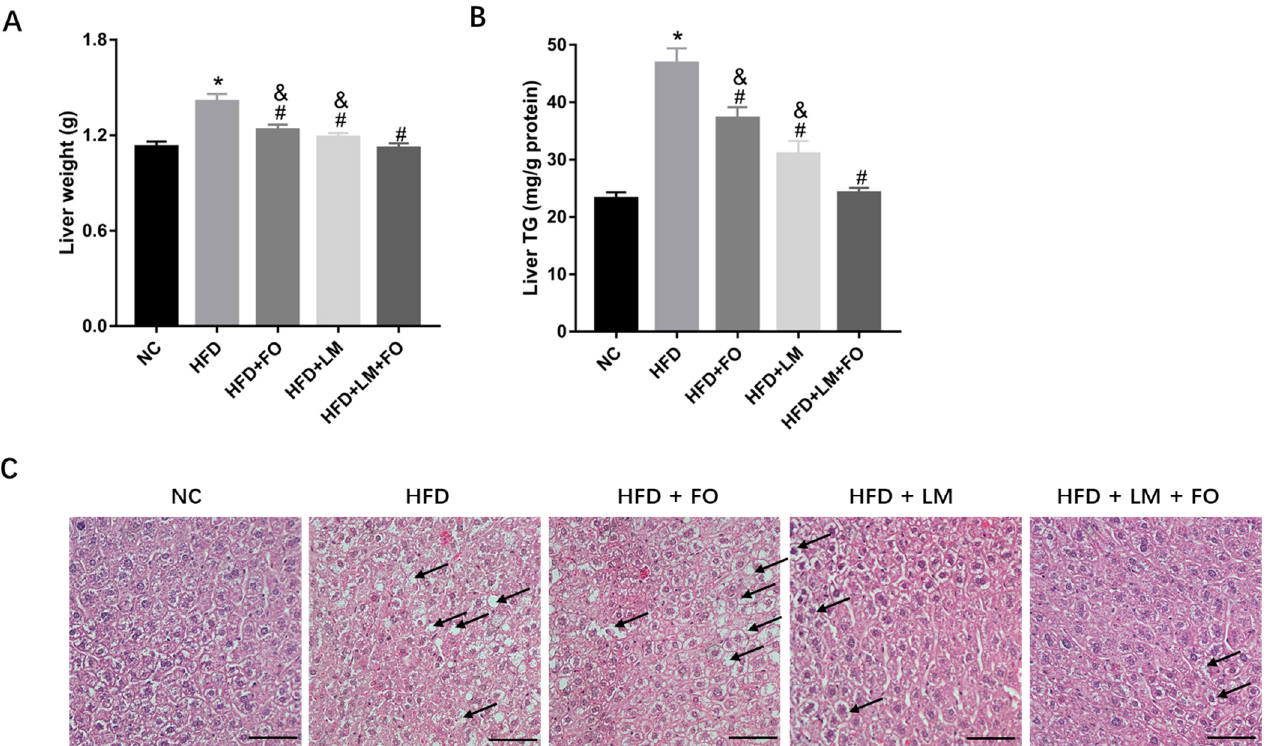
Figure 3. Effects of FO and LM on liver injury in HFD mice. ( A ) Liver weight determined after 9 weeks of treatment. ( B ) TG levels in liver determined as described in the text. ( C ) Histological analysis of liver sections evaluated after hematoxylin and eosin (H&E) staining (400×, scar bar = 50 μ m). Black arrows indicated steatosis. Data are presented as means ± SD ( n = 3). * p < 0.05 vs. NC; # p < 0.05 vs. HFD; & p < 0.05 vs. LM + FO.